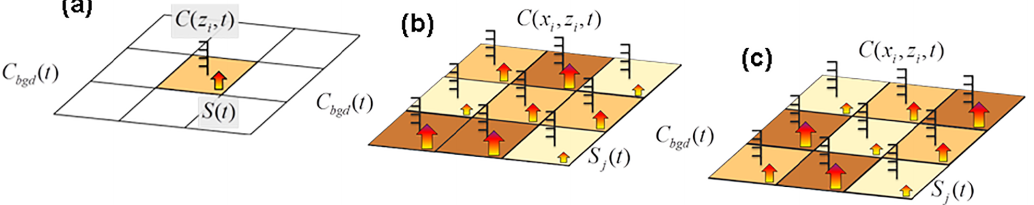
Figure 1. General scheme of the source receptor locations for (a) a single source and (b) multiple sources. (c) “Optimum” plot layout used for the multiple-source